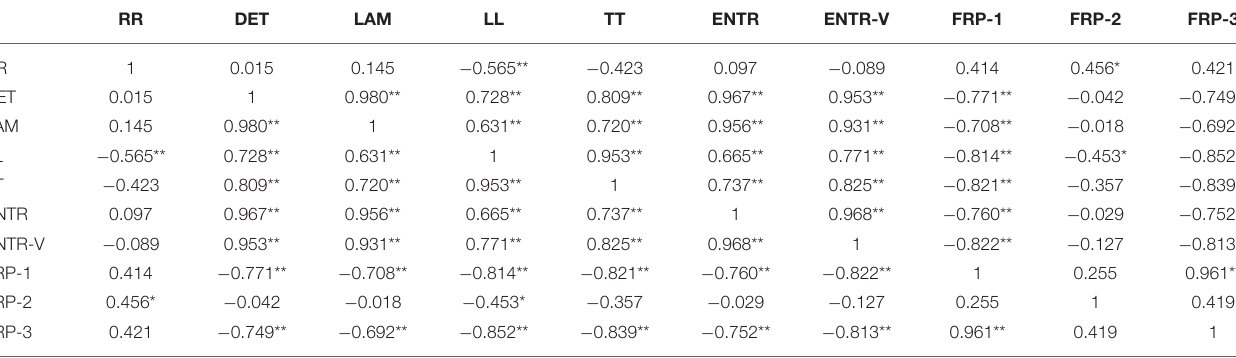
TABLE 3 | Inter-correlations between traditional and football-specific recurrence parameters for n = 21 matches (*significant correlations; **highly significant correlations).